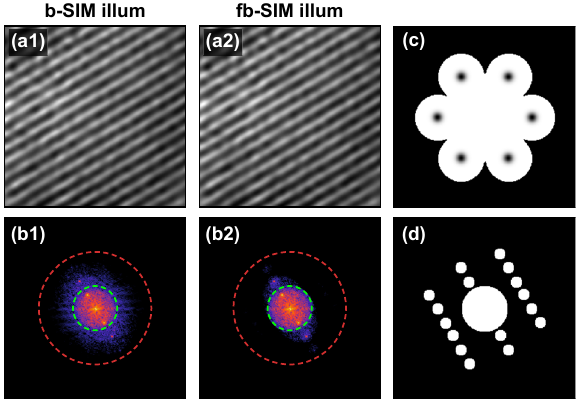
Figure 8: Reconstructed illumination. (a1,a2) The illumination patterns reconstructed using b-SIM and fb- SIM. (b1,b2) The Fourier transforms of (a1,a2). (c) The Fourier filter used to apodize the jRL reconstruction result in Figure 7(a8). (d) The Fourier fi lter used during fb-SIM